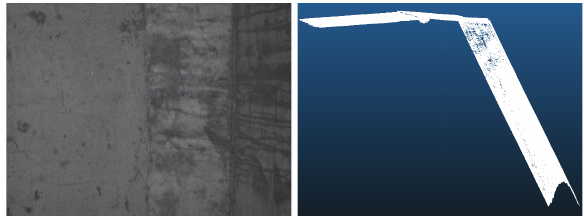
Figure 4: An example of dim structure line in a 2D image (Left), but obvious enough in the corresponding 3D cloud points (Right) collected by the 3D camera.